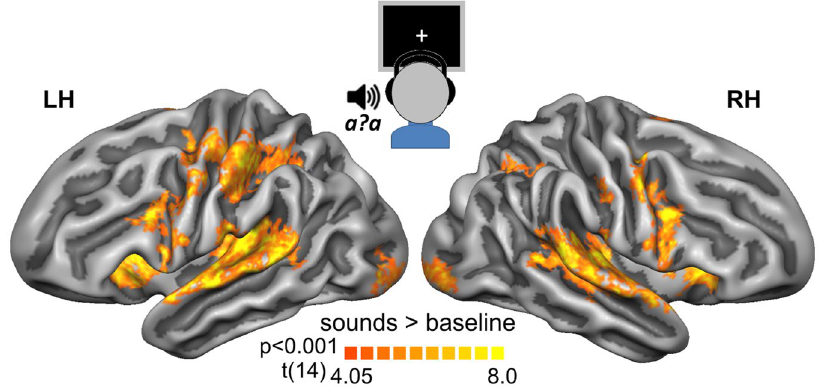
Figure 3. fMRI activity during auditory post-test trials. Functional maps illustrating activity evoked by the ambiguous post-test speech sounds. The maps are based on random effects contrasts, corrected for multiple comparisons using cluster size correction (p corr < 0.05) with a primary threshold of p vertex = 0.001, and visualized on cortical surface representations of the left (LH) and right (RH) hemispheres (light grey: gyri and dark grey: sulci), resulting from the realignment of the cortices of our 15